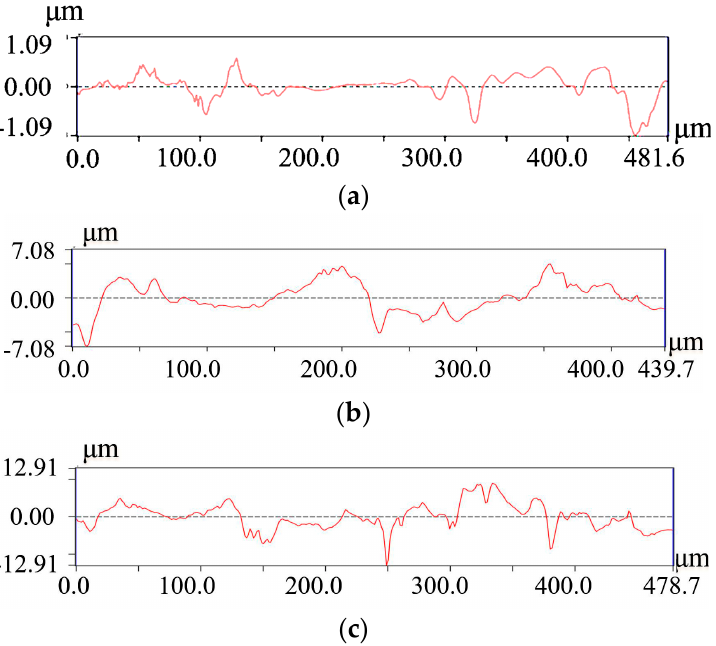
Figure 17. The profile curve of Inconel 718 the channel machining; ( a ) the channel hub; ( b ) the sidewall close to the inlet; ( c ) the sidewall close to the outlet.